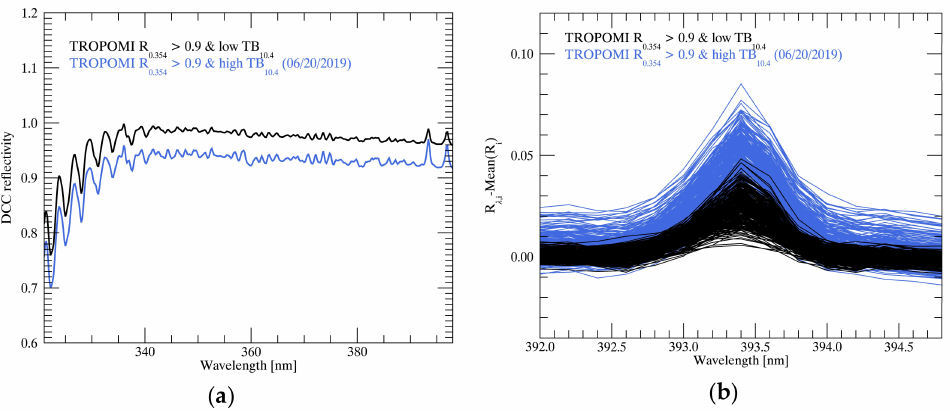
Figure 10. ( a ) Mean reflectivity spectrum of TROPOMI DCCs detected using UV reflectivity (TROPOMI R 0.354 > 0.9) and ( b ) spectral anomaly spectra (i: each DCC pixel, λ : wavelength). The black and blue lines represent a cold and warm IR temperature,